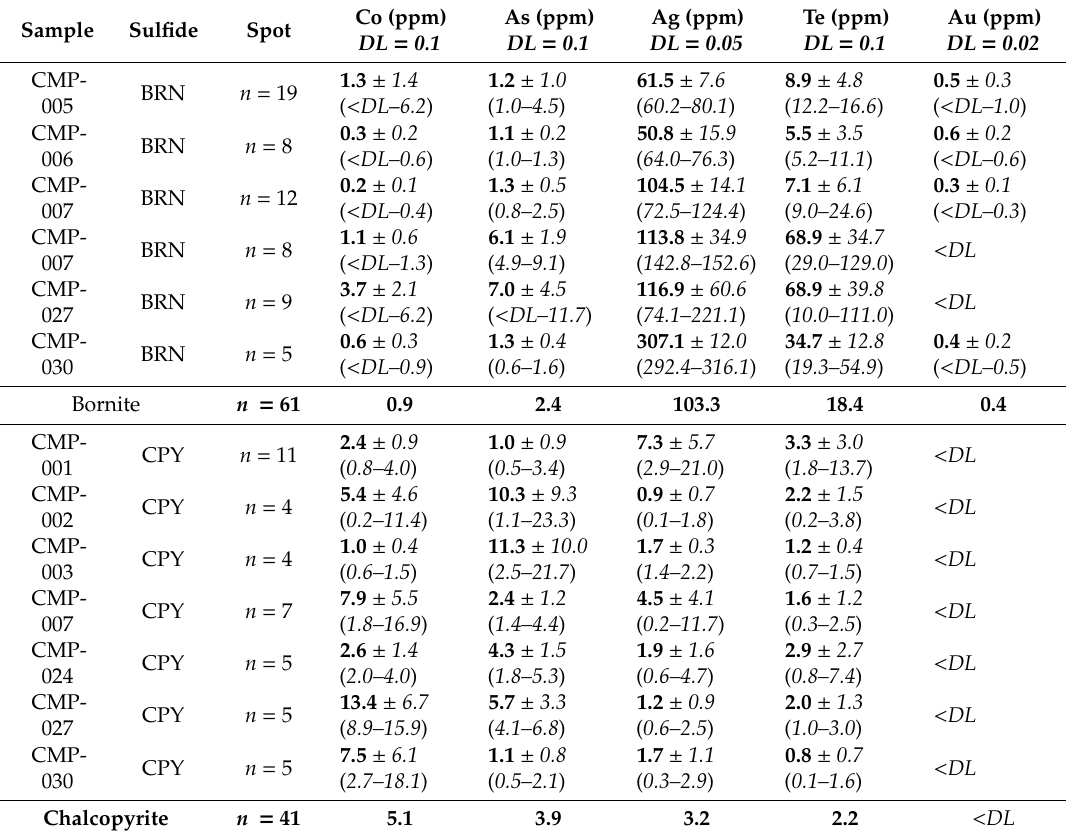
Average values (in bold) ± standard deviation and value range (in brackets) for selected trace-element concentrations. n : number of spot analyses. BRN = bornite; CPY = chalcopyrite. DL : limit of detection. CMP: critical metal project.